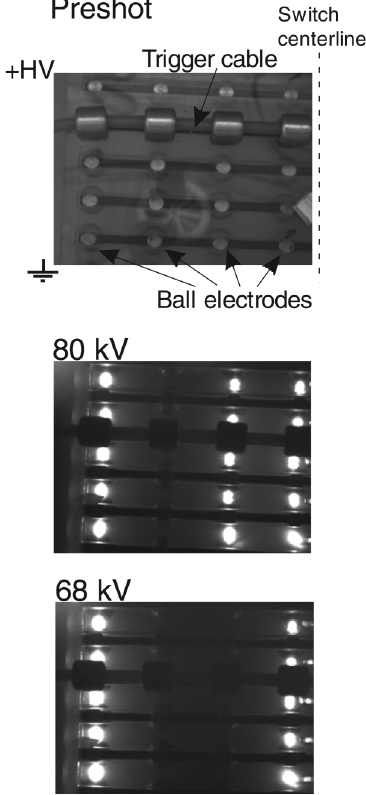
FIG. 4. Preshot and time-integrated images of switch block operation at different charge voltages (emission to the right of discharges on rightmost row is reflection from the Perspex cover on the switch block).